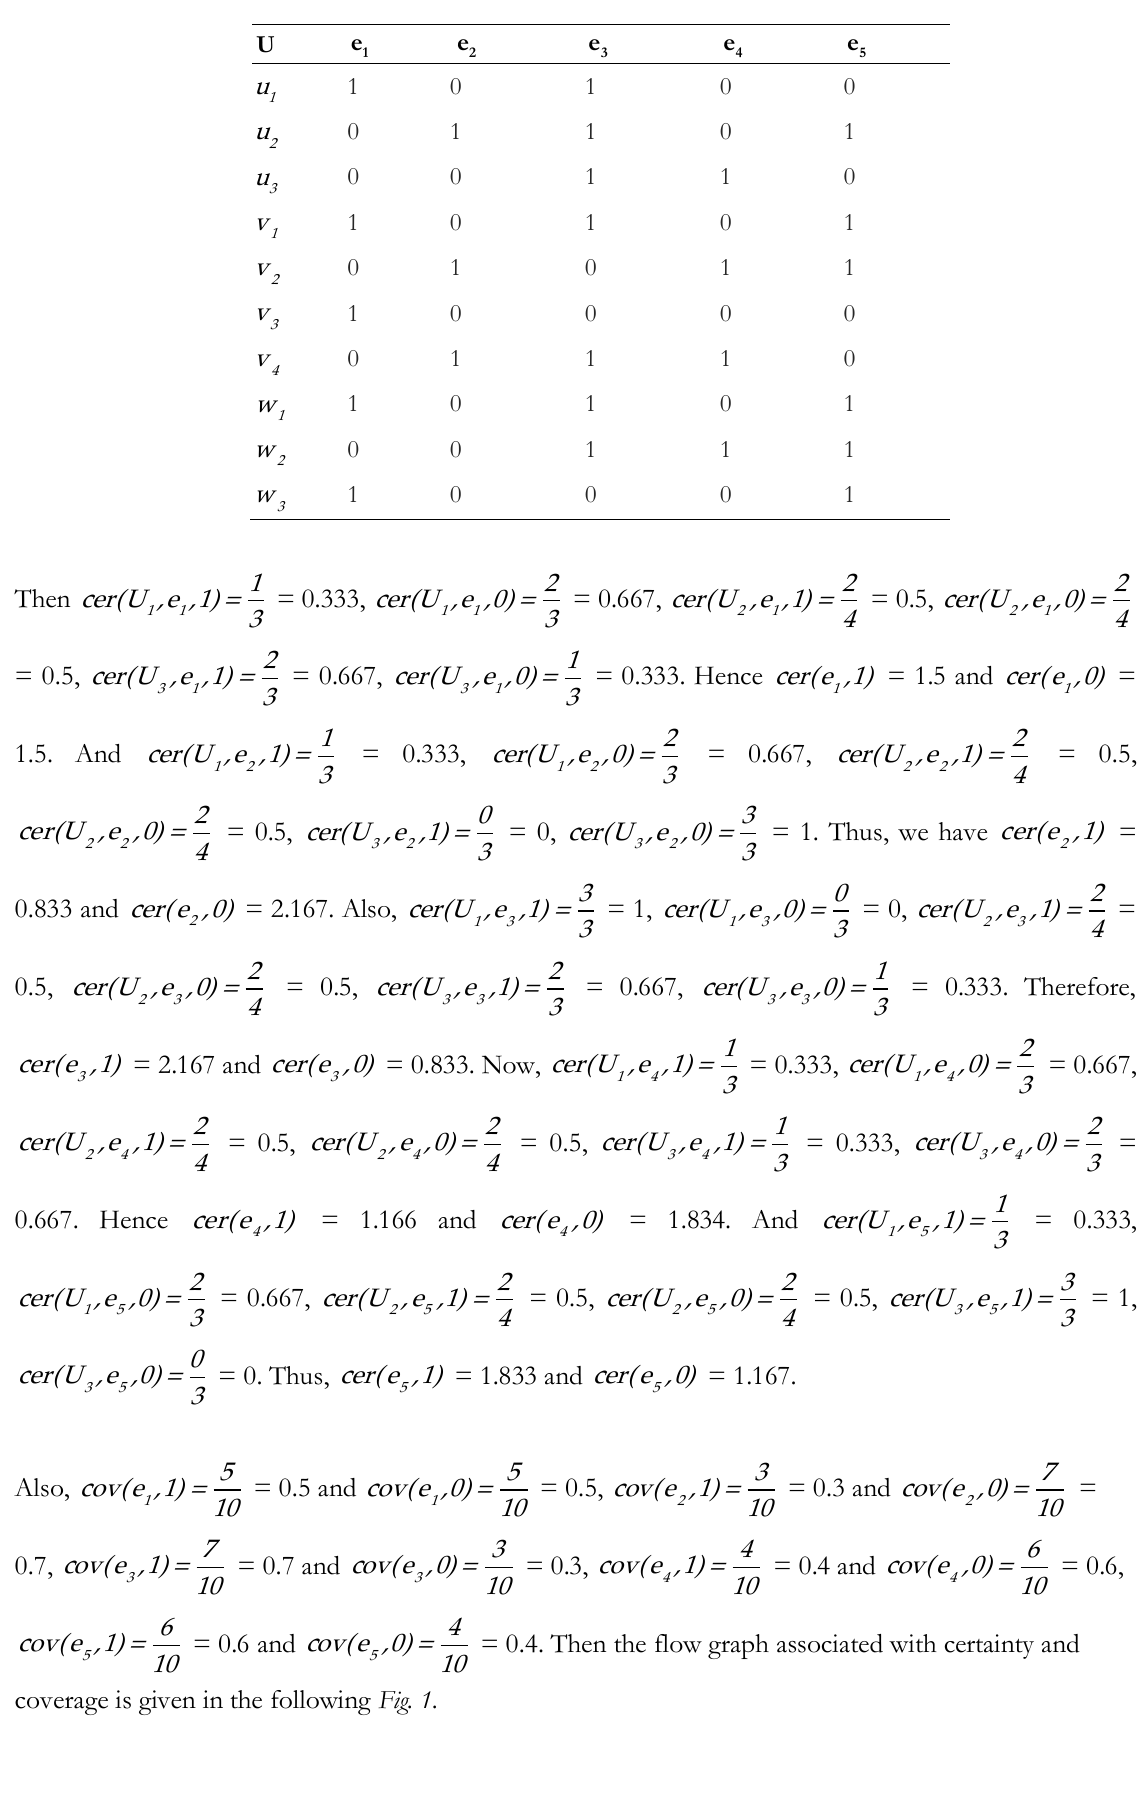
Table 2. Tabular representation of (F,